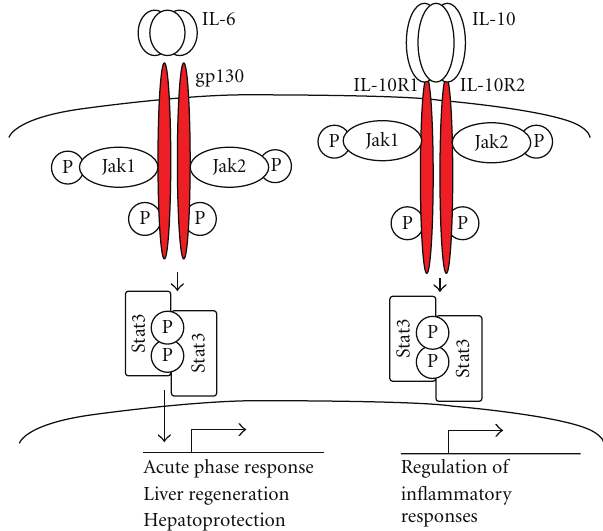
Figure 4: Schematic overview of Jak/Stat signaling pathways. IL-6 signals through gp130, which is a common receptor chain for IL- 6 and the IL-6 receptor. Hepatocytes express high level of gp130 and IL-6. IL-6 binding to its corresponding receptors leads to the dimerization of gp130, followed by dimerization of gp130- associated Jak 1 and Jak2, and phosphorylation of Jaks and gp130. This receptor-kinase complex then recruits and phosphorylates cytoplasmic protein Stat3. Phosphorylated Stat3 forms dimers, translocates into the nuclei, and induces gene transcription. Binding of IL-10 to its corresponding receptors IL-10R1 and IL-10R2 leads to Jak and then Stat3 phosphorylation, which then functions as a transcription